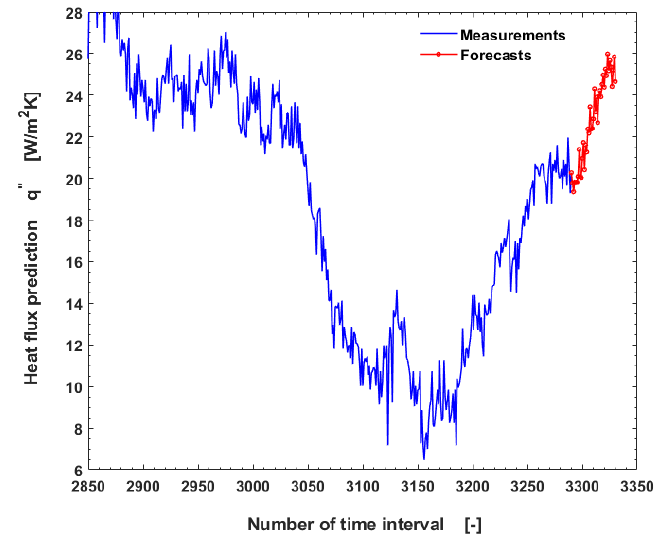
Figure 9. Right enlarged view of Figure 8c, multistep time interval of 180 s.